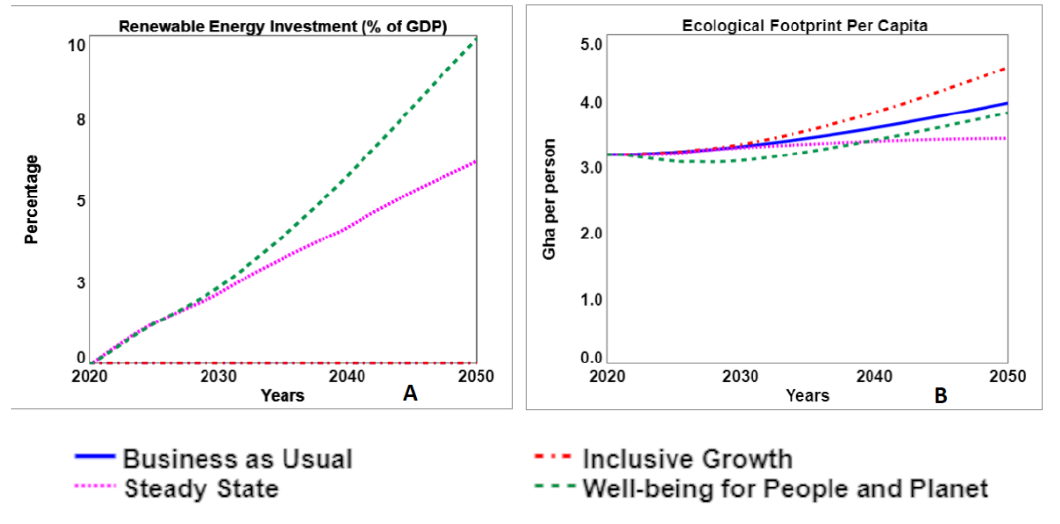
Figure 10. Renewable energy investment within GDP and ecological footprint per